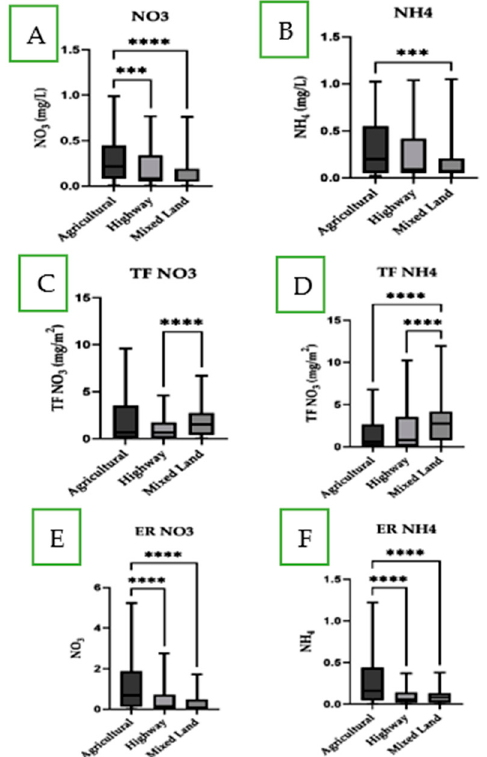
Figure 2. Box-whiskers plots showing differences among sites in the concentration ( A , B ), fluxes ( C , D ), and enrichment ratios ( E , F ) of NO 3 − and NH 4 + . Lines connect sites that were significantly different from each other, and the asterisks show the level of statistical significance. ( p = 0.05, p < 0.01, *** p < 0.001, **** p < 0.0001).